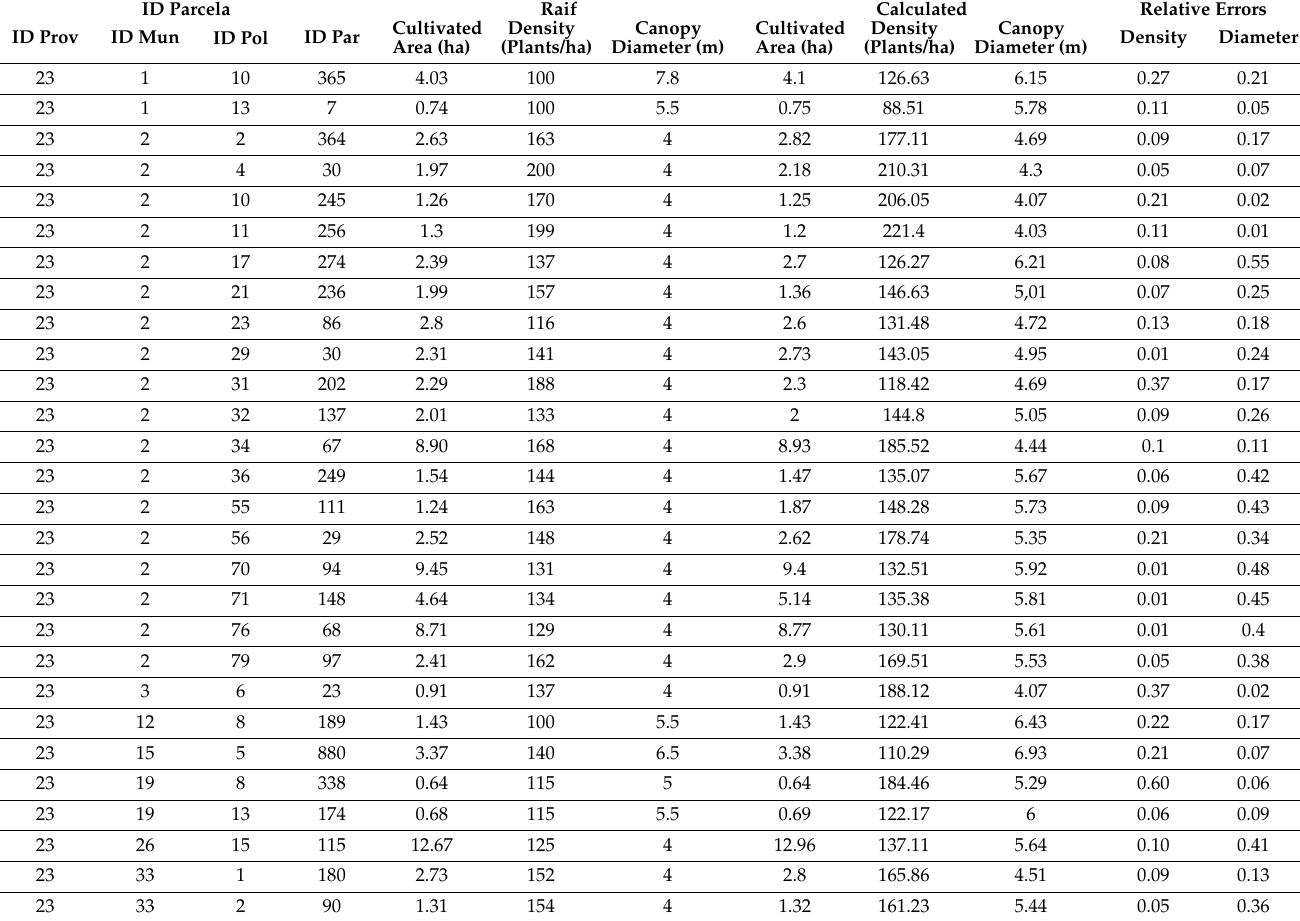
Table 5. Comparative table of the data provided by the RAIF and the estimates made with the developed